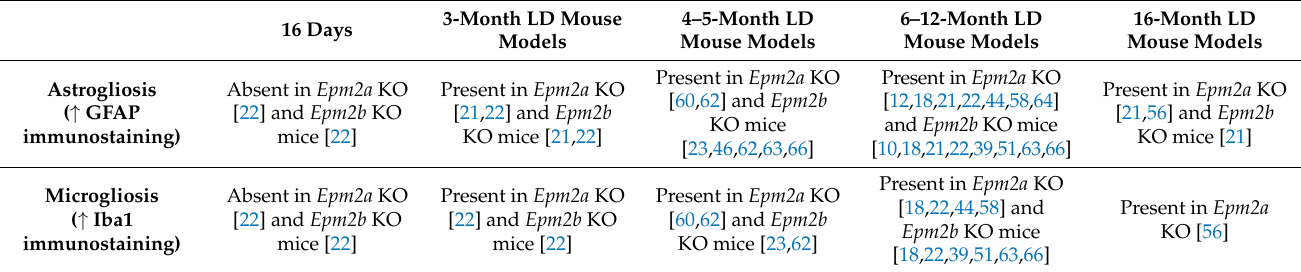
Table 1. Neuroinflammation in mouse models of